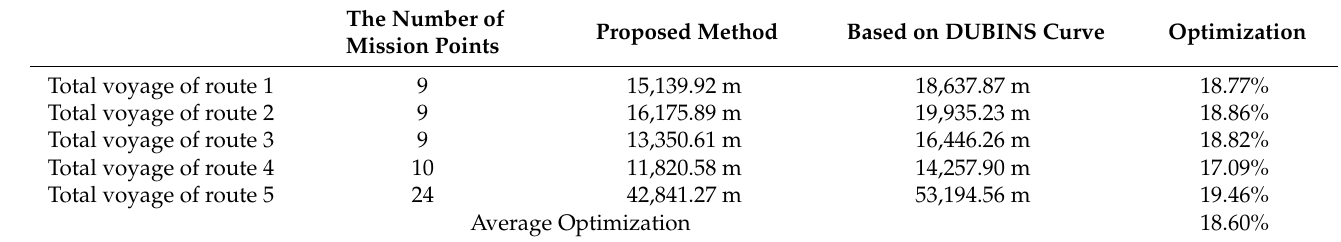
Table 2. Comparison of simulation results of two route planning